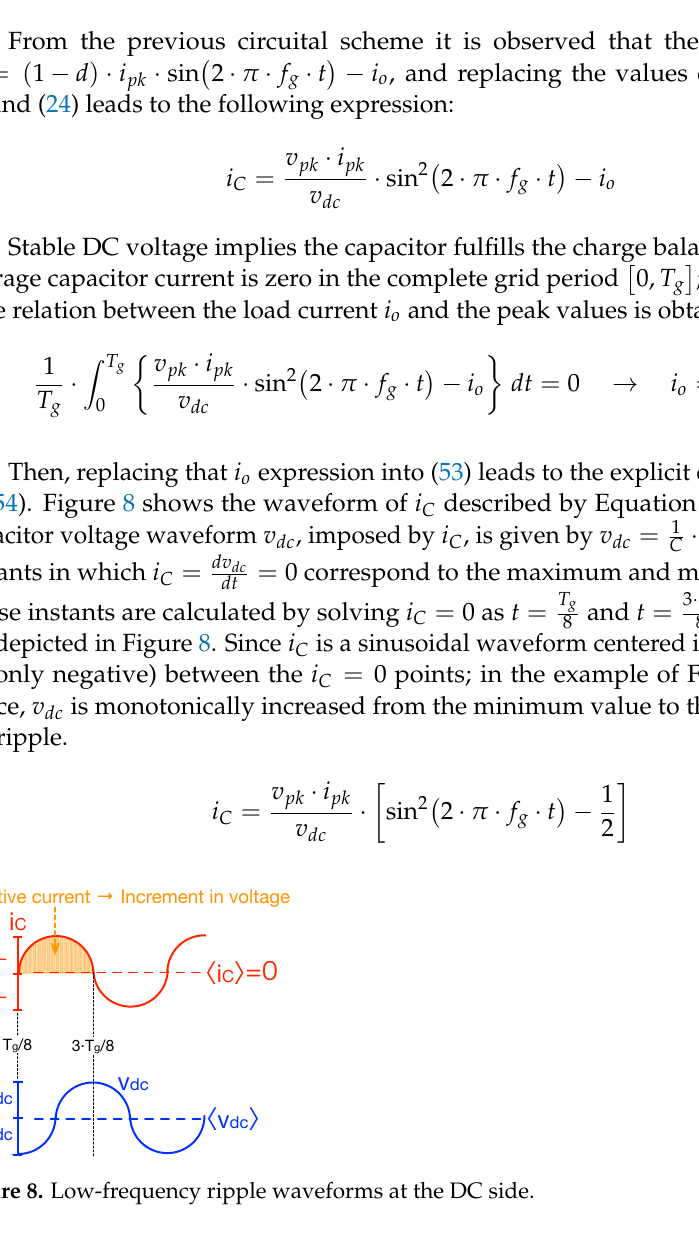
Figure 7. Output port model for analyzing the low-frequency voltage ripple at the DC side.